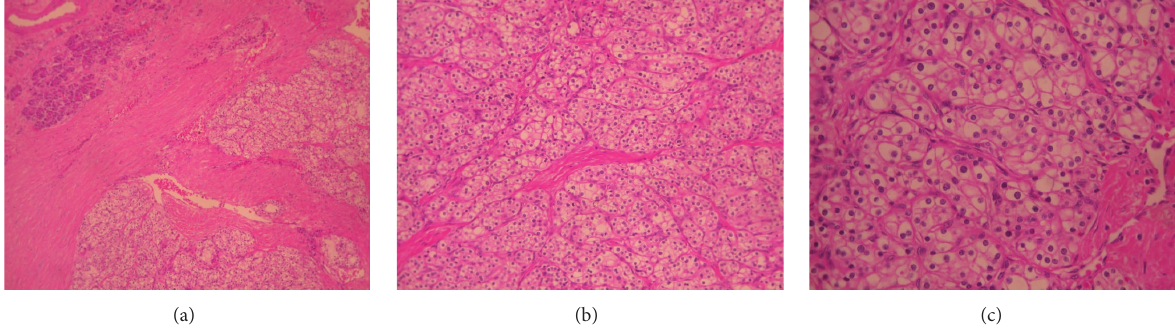
Figure 2: Histological examination. (a) The tumor shows well-defined borders with thick fibrous capsule (H&E × 100). (b) Clear cells in solid nests and few tubules (H&E × 200). (c) Clear cells in solid nests with round nuclei without atypia or mitoses (H&E ×